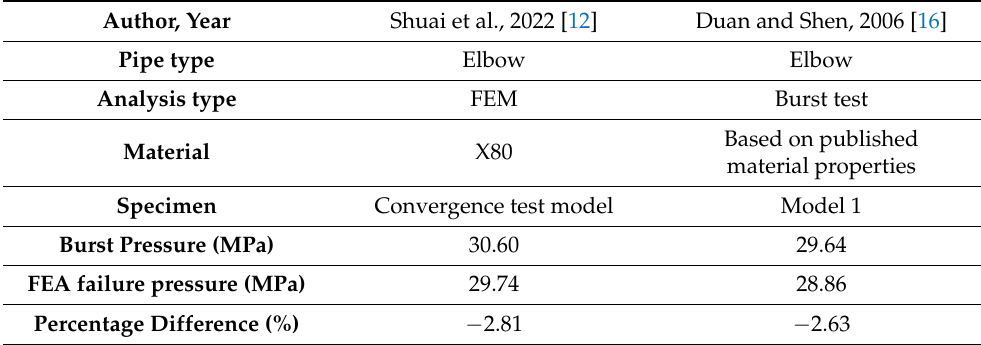
Table 3. Results of the FEM validation